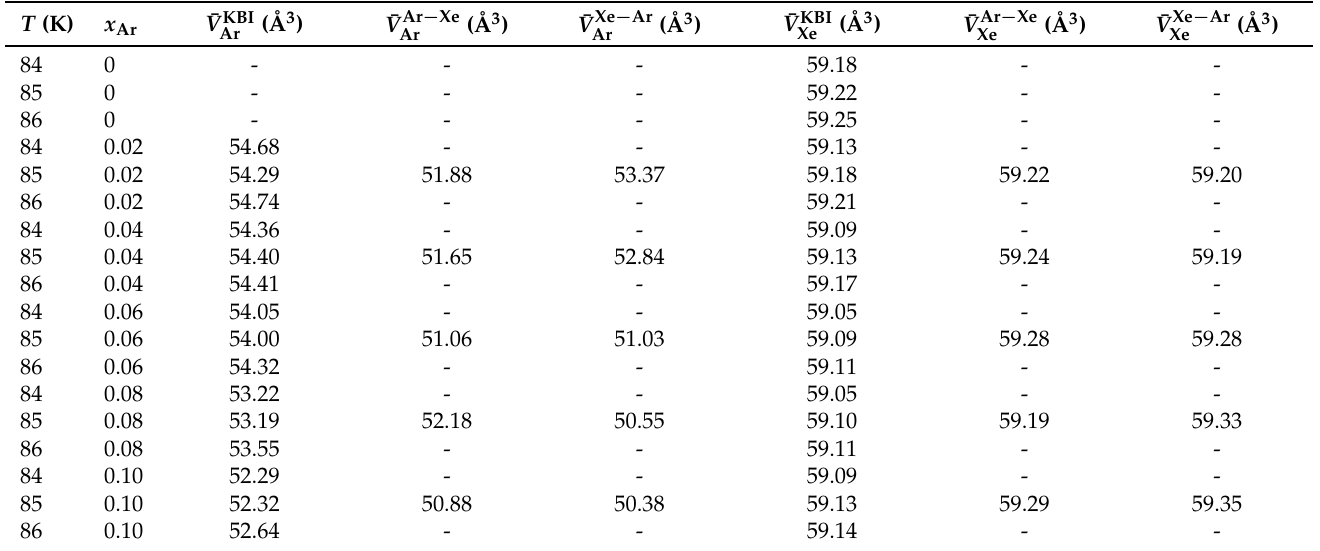
Table 3. Partial molar volumes ¯ V Ar and ¯ V Xe obtained either using KBI theory ( ¯ V KBI ) or from two NpT simulations and Equation (21) with particle numbers ( N Ar , N Xe ) corresponding to x Ar and ( N Ar ± 1, N Xe ∓